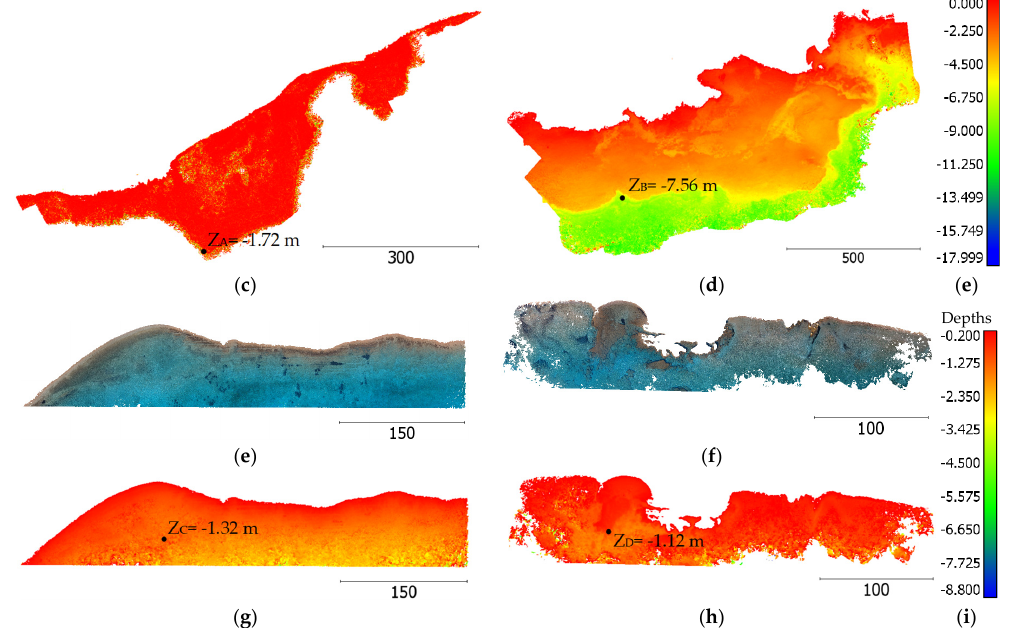
Figure 3. The initial seabed point clouds for Amathounta ( a ), Agia Napa ( b ), Cyclades-1 ( e ), and Cyclades-2 ( f ) test sites. Their corresponding bathymetry is illustrated in ( c ), ( d ), ( g ) and ( h ) respectively while in ( e ) and ( i ) is illustrated the color scale of the depths. Z X is the uncorrected depth of the point marked with the black dot in each point cloud. Scale bars and depths are in meters.